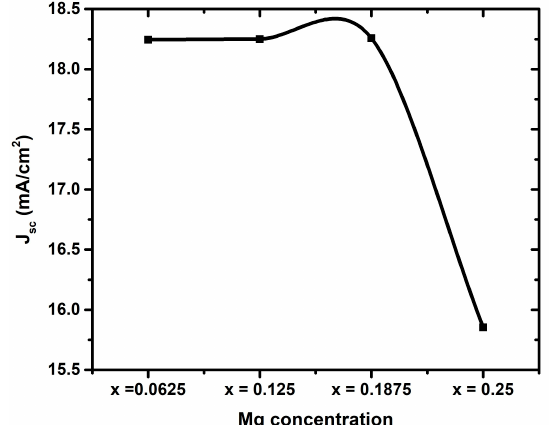
Figure 5 . Variation in the short circuit current (J sc ) by increasing the Mg concentration in Zn 1 − x Mg x